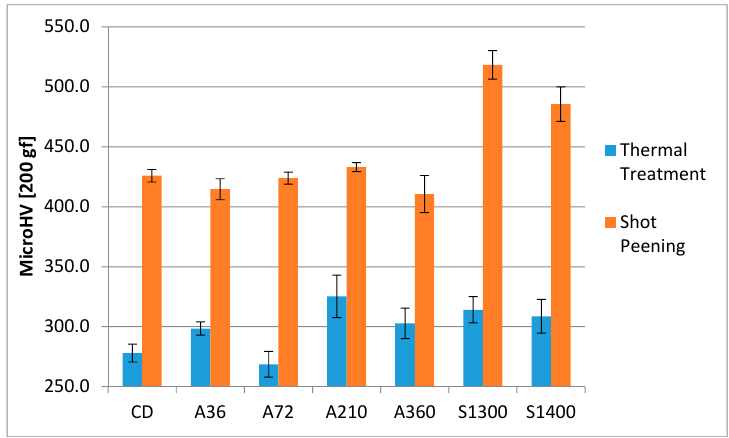
Figure 4. Surface hardness before and after shot peening treatment.